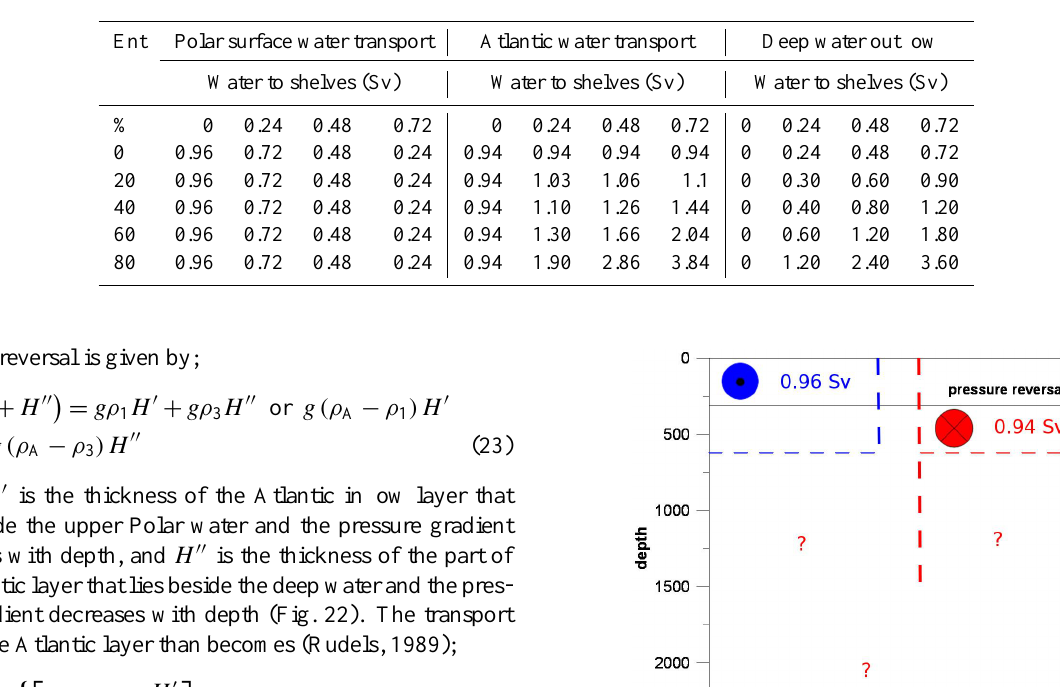
Table 2. Transports of Atlantic water, Polar surface water and deep water for different amount of Polar surface water transformed on the shelves and different percentages of entrained ambient (Atlantic) water.